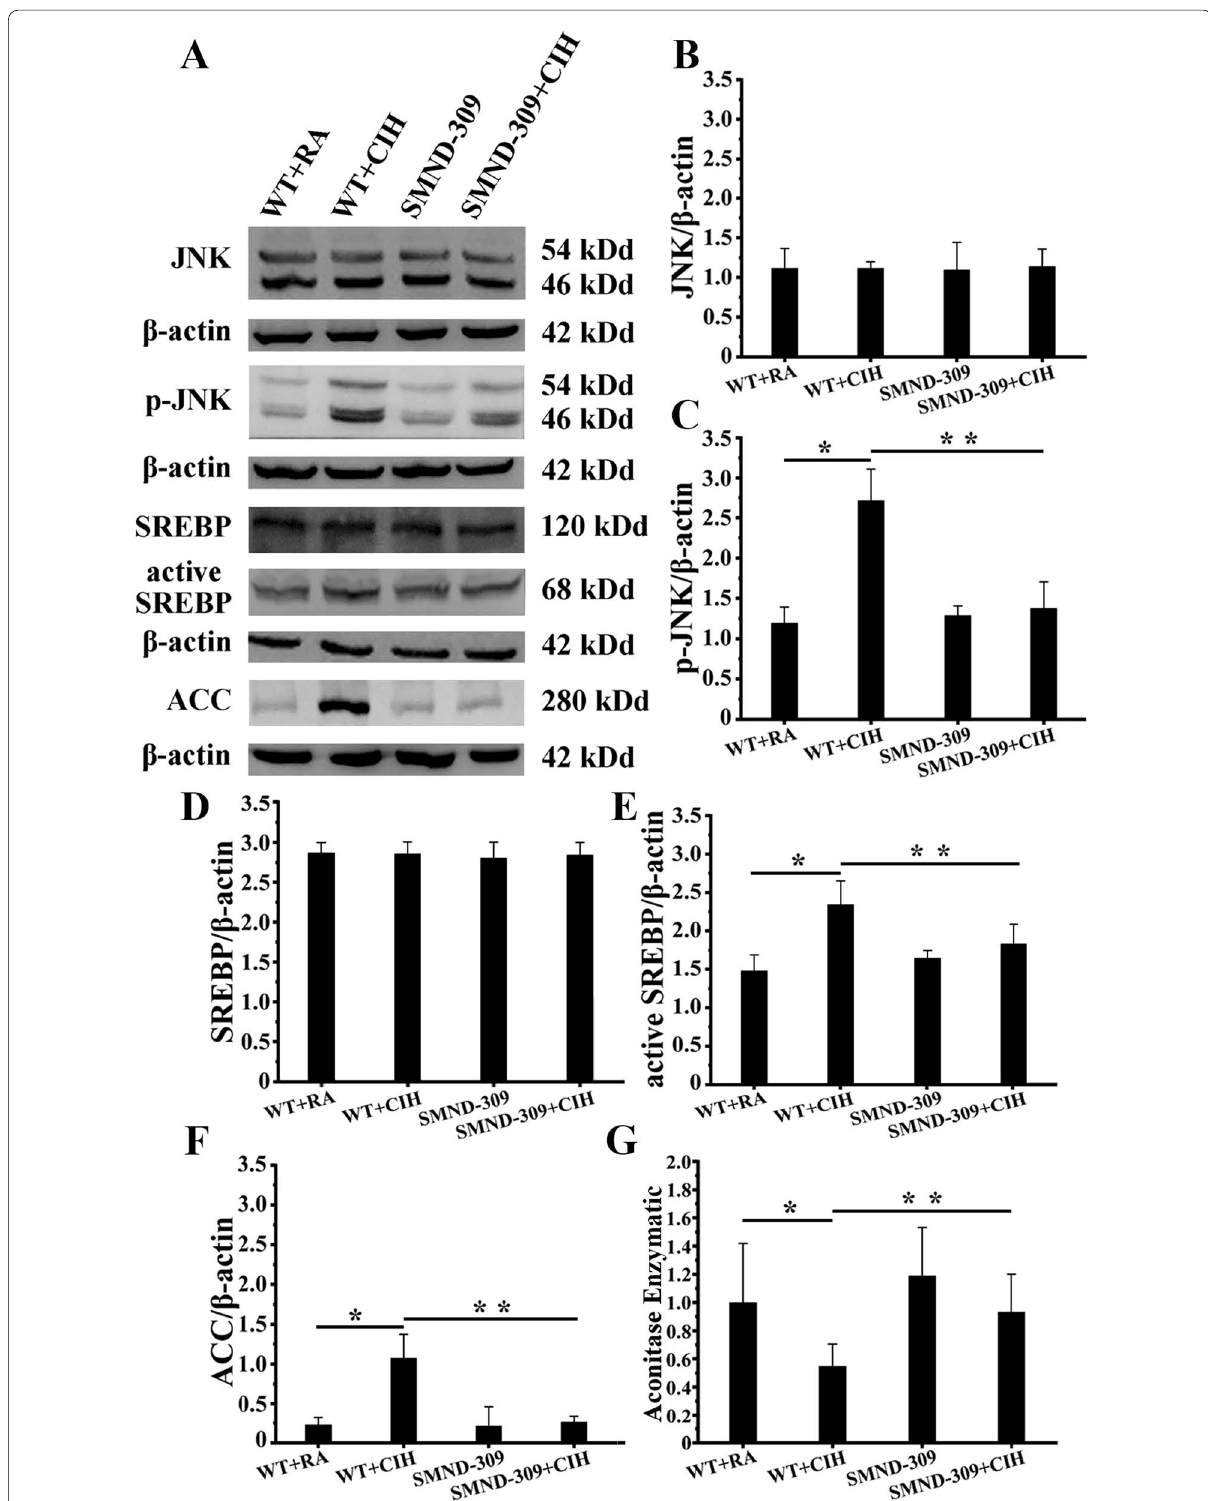
Fig. 9 ROS level and JNK/SREBP/ACC expression. A – G The ROS level was highly enhanced in the hippocampus of WT the JNK/SREBP/ACC pathway was activated. However, these changes were attenuated by SMND-309 treatment (p < 0.05). *p < 0.05 WT group vs. WT CIH group. **p < 0.05 WT CIH group vs. SMND-309 CIH group. All experiments were repeated three times. Data are expressed as the mean Statistical analysis was performed through two-way